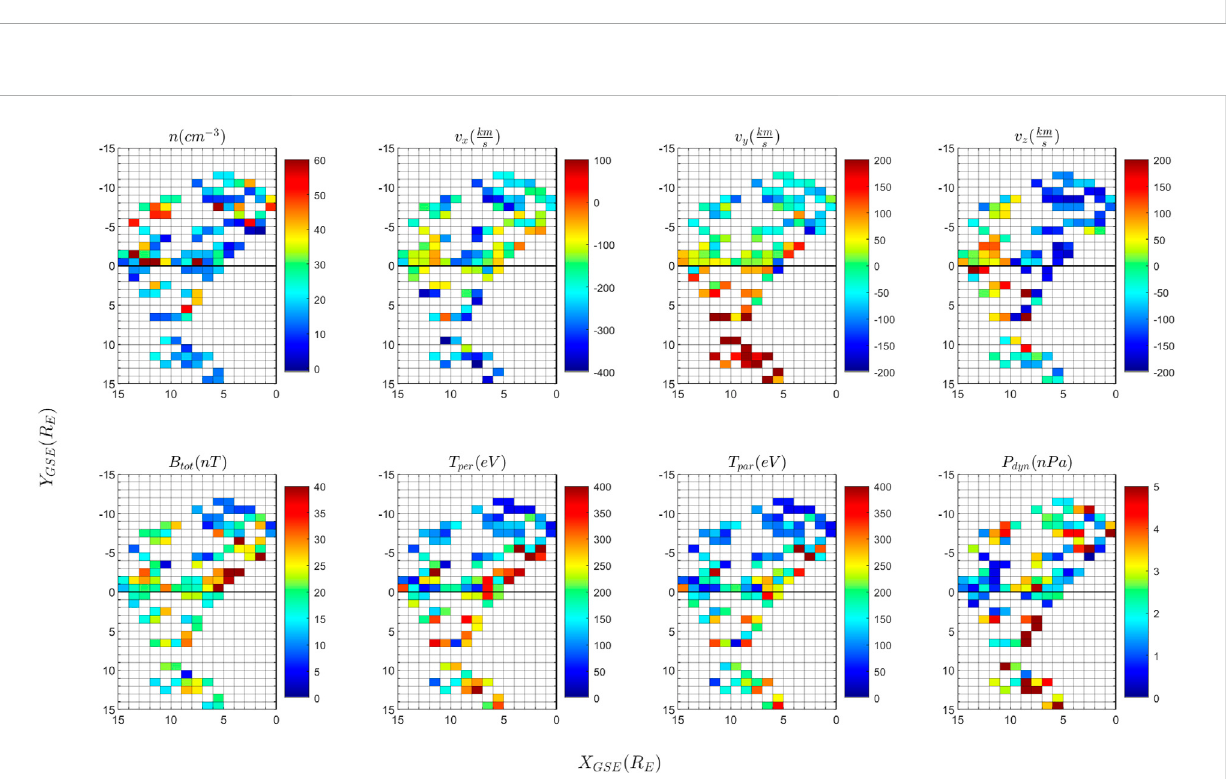
FIGURE 4 Summary of dynamical properties of magnetosheath jets observed by Cluster 3 between January and April 2007. The panels show the plasma density ( n ), the three components of the plasma bulk velocity ( v x ,v y ,v z ), the magnetic fi eld intensity ( B tot ), the parallel and perpendicular temperature ( T per , T par ), the dynamic pressure ( P dyn ). The value of the parametersis color coded as shown in the tablesnext to the panels; the values in each spatial bin are estimated as the median of the respective parameter for the ensemble of all jets detected in the respective bin. Only one value per jet is considered, namely, the one measured at the time when the dynamic pressure is maximum (indicated with stars in Figure